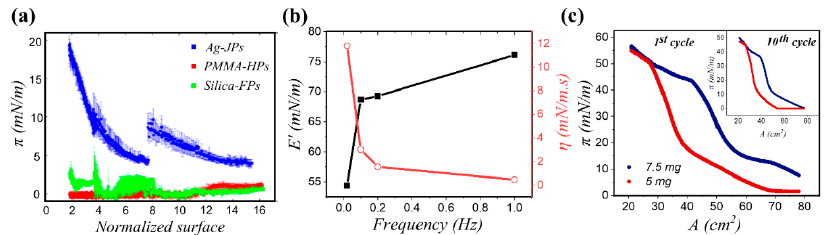
Figure 6. (Color online) Examples of dilational rheology response of Janus particle-laden fluid interfaces. ( a ) Surface pressure isotherms for different particles at decane/water interface. In this study, the Janus particle samples (Ag-JPs) exhibited a higher surface pressure when compared to both homogeneous particle samples; i.e., poly(methyl methacrylate) (PMMA-HPs) and silica particles func- tionalized with methacryloxypropyltrimethoxysilane molecules (Silica-FPs). The normalized area is defined as the total drop area divided by the area occupied by the nanoparticles assuming hexagonal packing at the interface and 100% binding efficiency upon deposition at the interface; ( b ) Repro- duction of Figure 6 from Ref. [237] depicting both elastic modulus (E’) (solid black symbol) and interfacial viscosity ( η ) (open red symbol) for the highest concentration of particles in ( a ) deposited at the interface ( 2.2 × 10 5 nm 2 /particle ). ( c ) Surface pressure isotherms for high amphiphilicity Janus particles at different concentrations deposited at the air/water interface. Main figure and the inset display the first and tenth cycle of compression, respectively. Panel ( a ) reprinted with permission from Ref. [87], copyright 2021 American Chemical Society. Panel ( b ) adapted from Ref. [237] copy- right 2021, with permission from Elsevier. Panel ( c ) taken from Ref. [107], with permission from the American Chemical